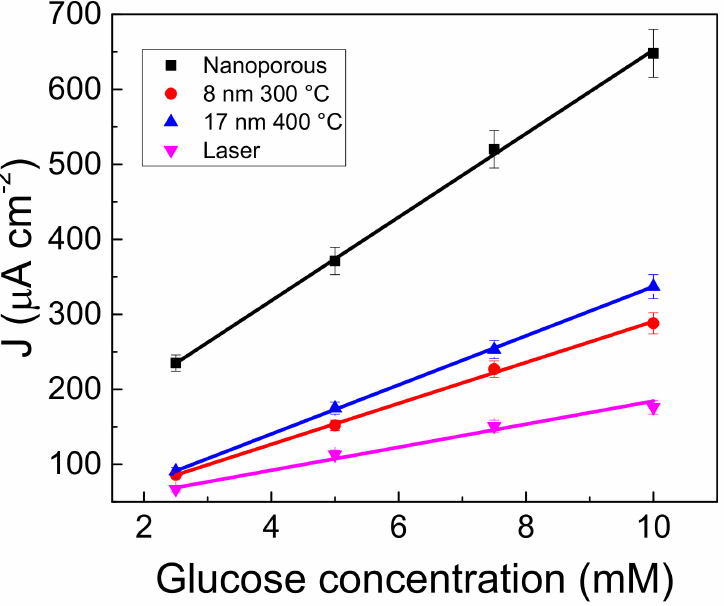
Figure 7. Calibration curves for the glucose determination in amperometric mode. Condition: NaOH 0.1